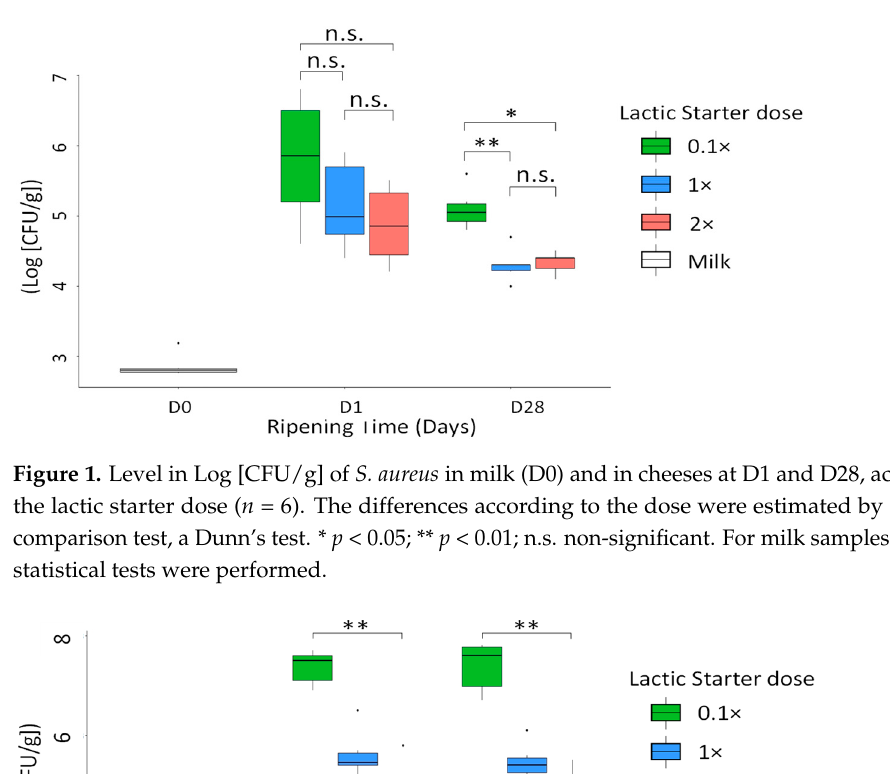
Figure 1. Level in Log [CFU/g] of S. aureus in milk (D0) and in cheeses at D1 and D28, according to comparison test, a Dunn’s test. * p < 0.05; ** p < 0.01; n.s. non-significant. For milk samples ( n = 6), no statistical tests were performed.